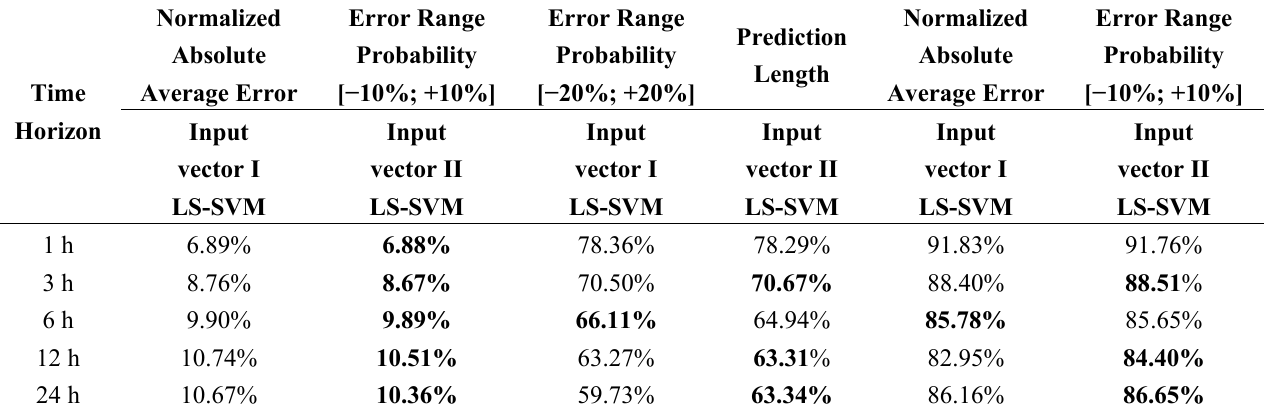
Table 4. NMAE and Error Range Probability for input vector Type I and Type II by LS-SVM prediction